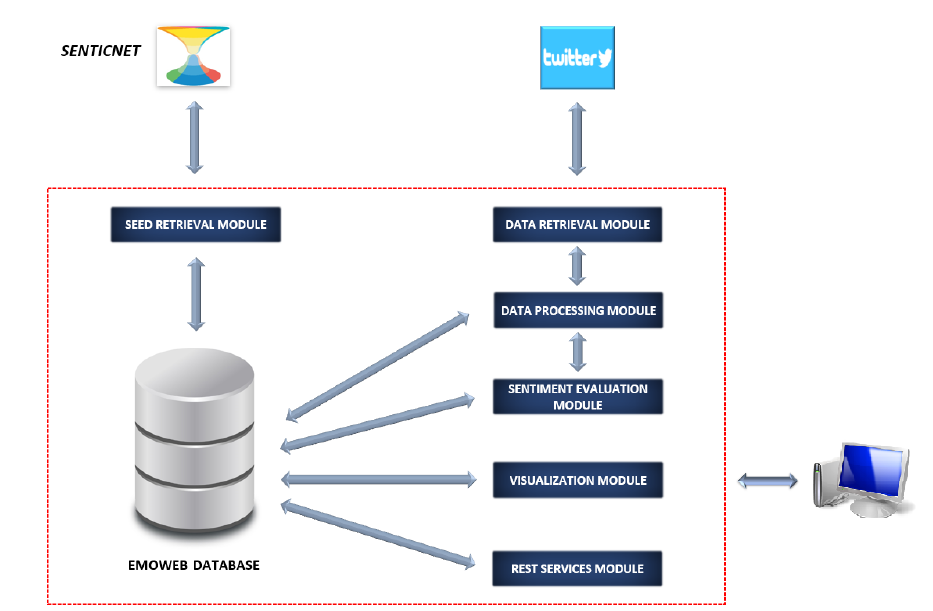
Figure 3. The EmoWeb framework